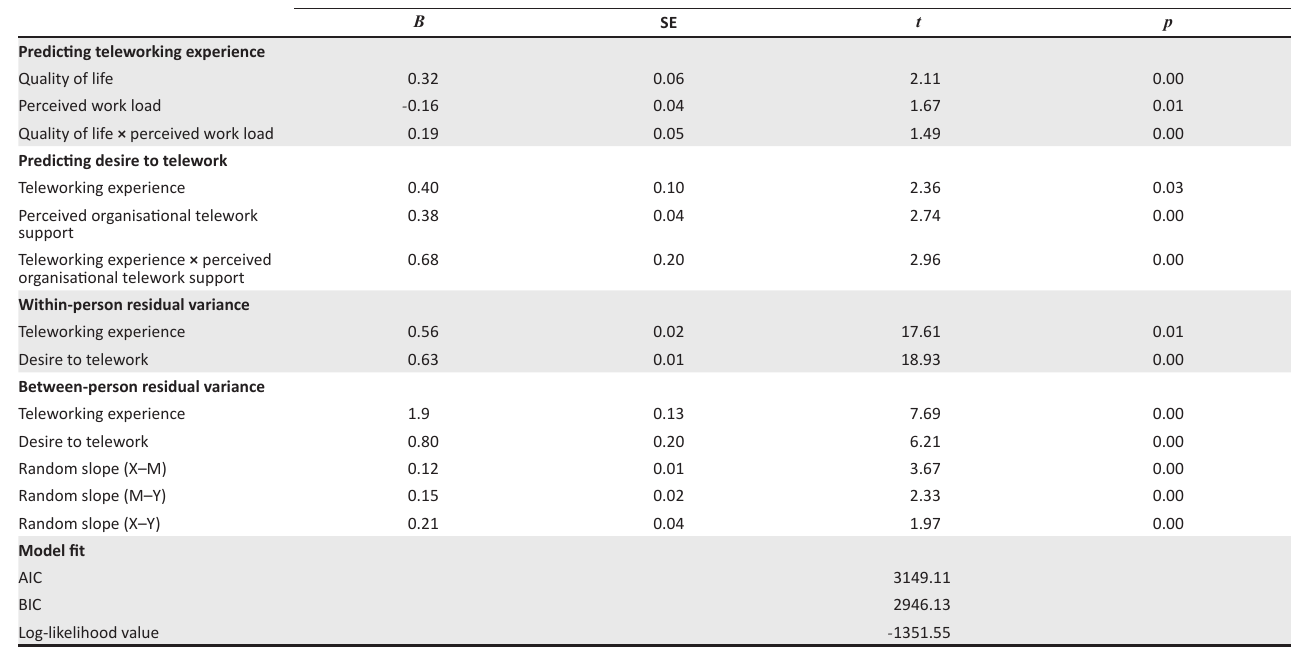
TABLE 1: Full hypothesised random slopes model with cross-level moderations.